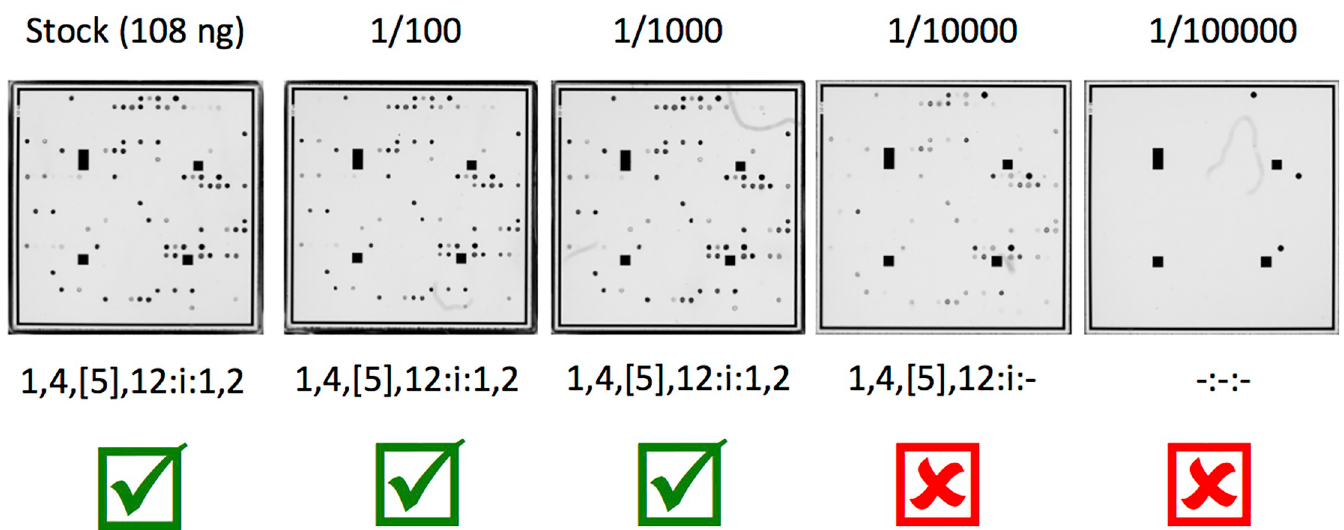
Fig 2. SGSA v. 2 array images processed by the Alere ArrayMate for the reference Salmonella ser. Typhimurium (1,4[5],12:i:-). A DNA stock was serially diluted and used as input into the SGSA v. 2 and imaged using the Alere ArrayMate system. The processed image files were used to create probe signal intensity files, which were used as input to the array classifier. Probe signals are consistent from the stock to a 10 − 3 dilution factor. Probe signals begin to be lost at 10 − 4 dilution and no signals are observed at 10 − 5 dilution. The limit of detection was set at 10 − 3 since it was the lowest dilution to completely identify the sample.